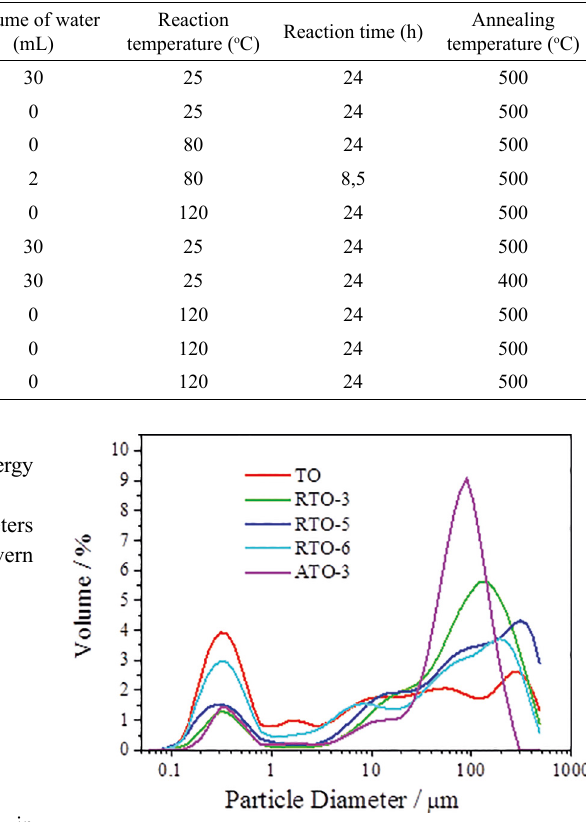
Figure 1. Particle size distributions of the different